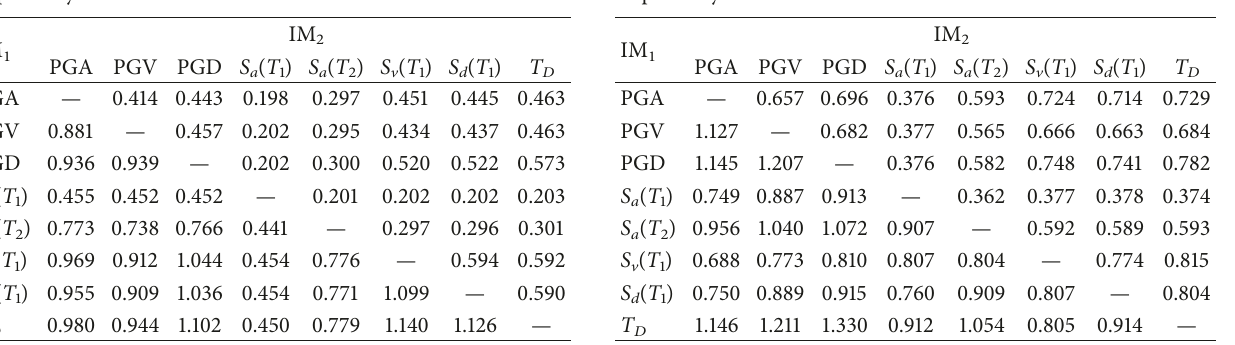
1 ,IM 2 . The upper and lower tri-